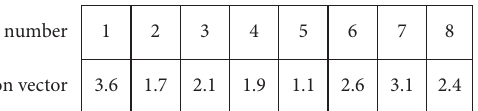
Figure 3: Decoding process of the hybrid